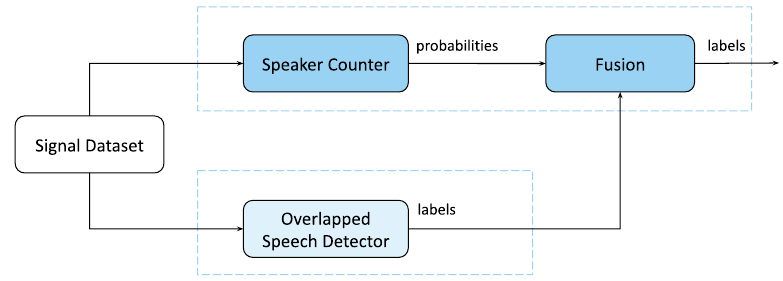
Figure 5. Diagram of speaker counter and overlapping speech detector fusion.